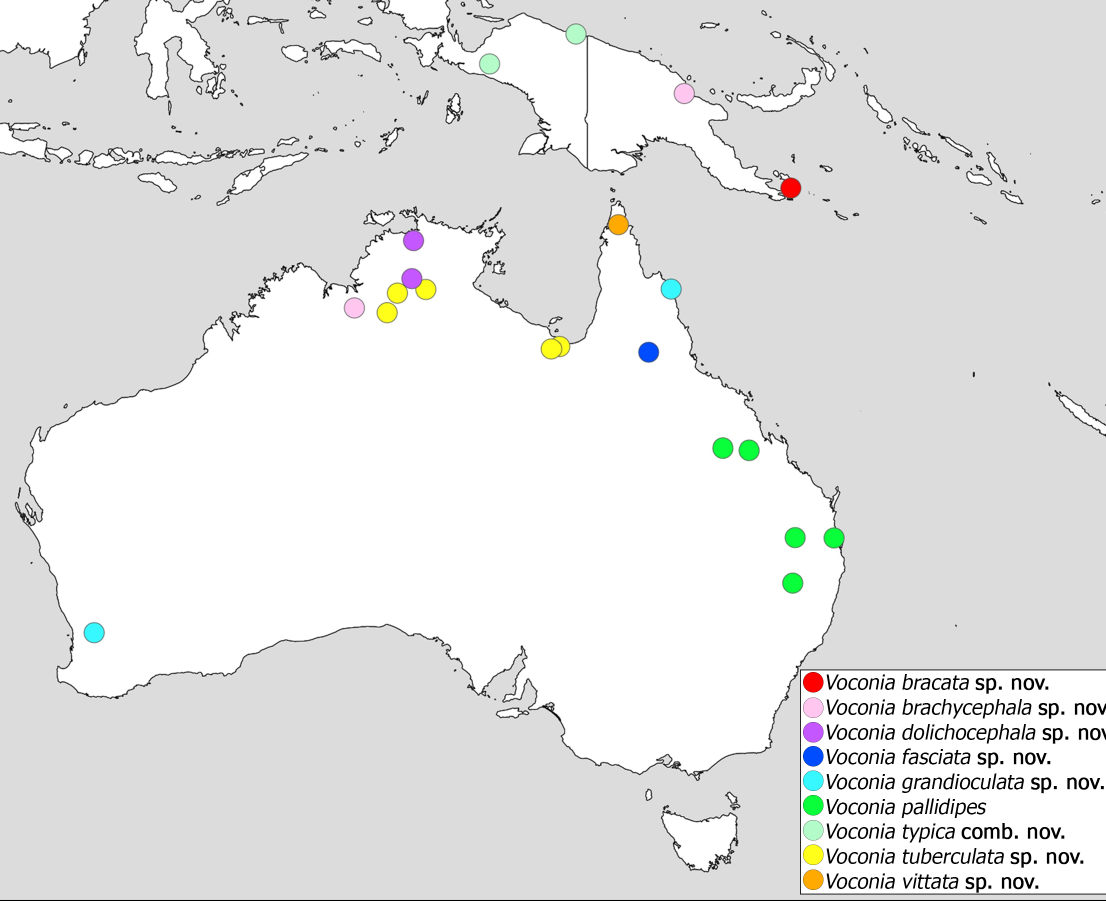
Fig. 18. The distribution of species of Voconia Stål, 1866 in the Australasian